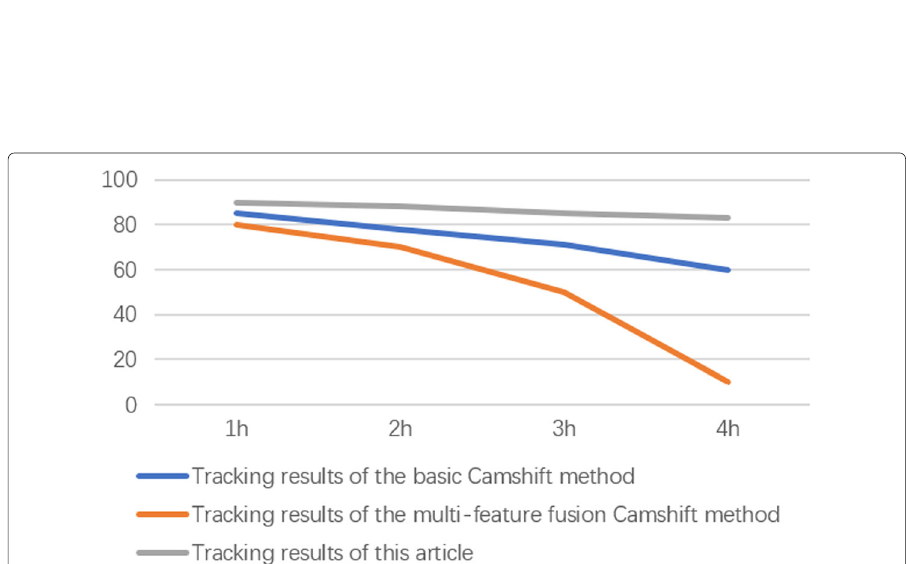
Fig. 9 The MT rate of the tracking targets for the three